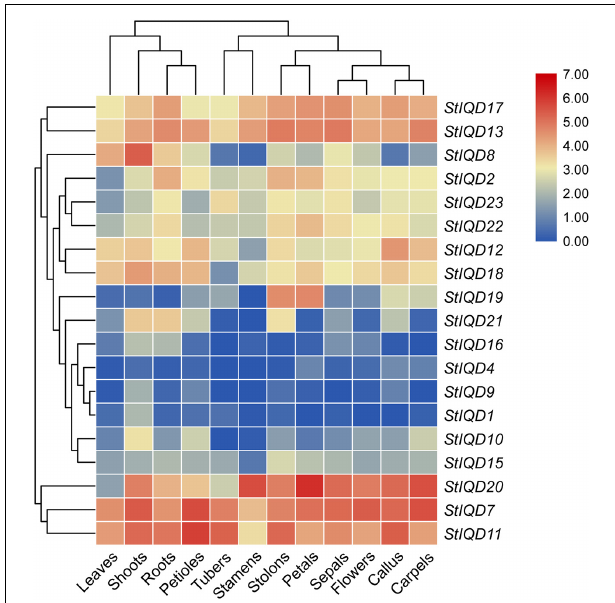
FIGURE 5 | Hierarchical clustering of expression values of StIQD in 12 tissues. Red indicates high expression level; blue, low expression